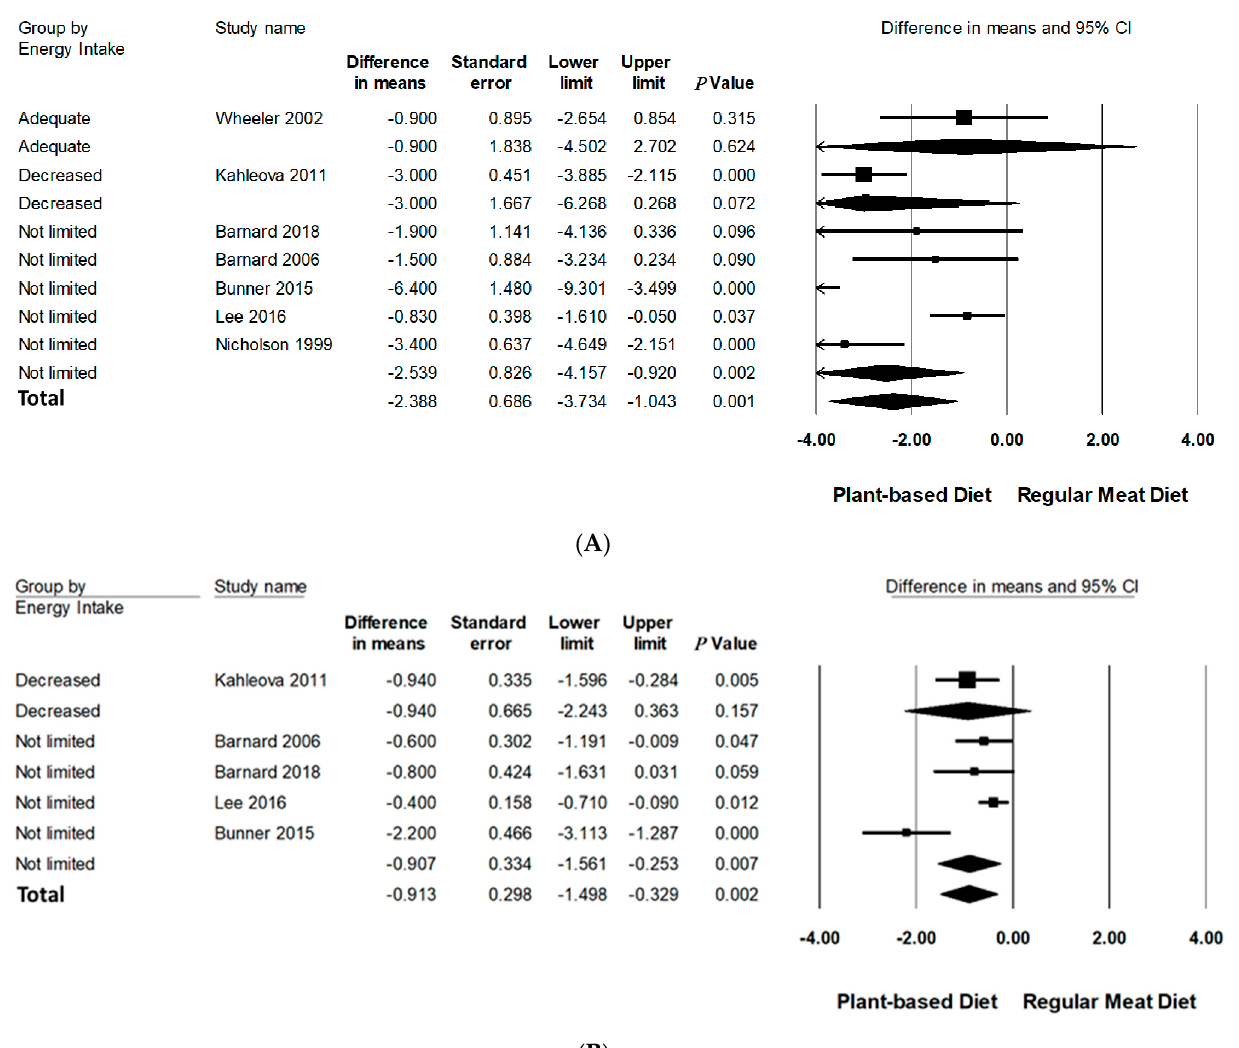
Figure 3. Forrest plots displaying differences in means (MD) and 95% CI for the impact of energy intake of PBDs compared to RMDs on ( A ) body weight (kg) [29–35] and ( B ) BMI (kg/m 2 ) [29,30,32–34].